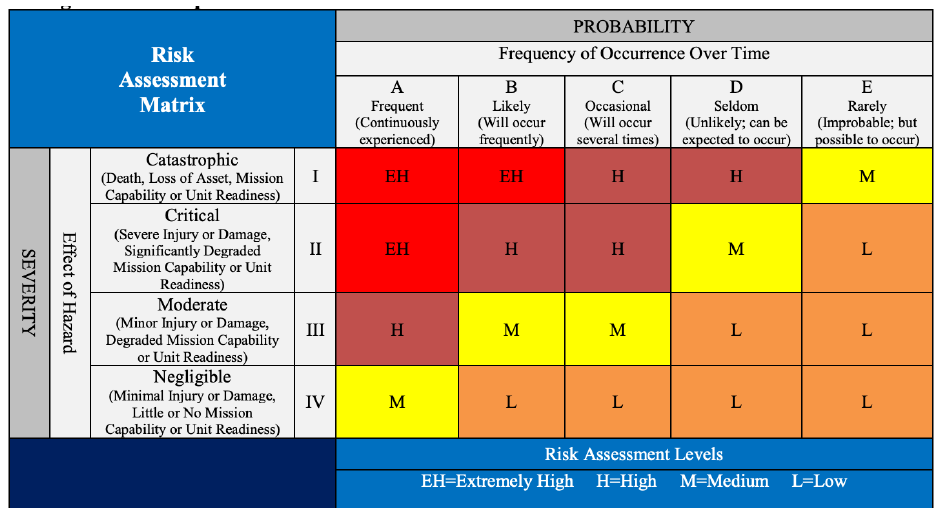
Figure 1. Doctrinal USAF risk assessment matrix. Adapted from: United States, Department of Defense, Department of the Air Force [6].